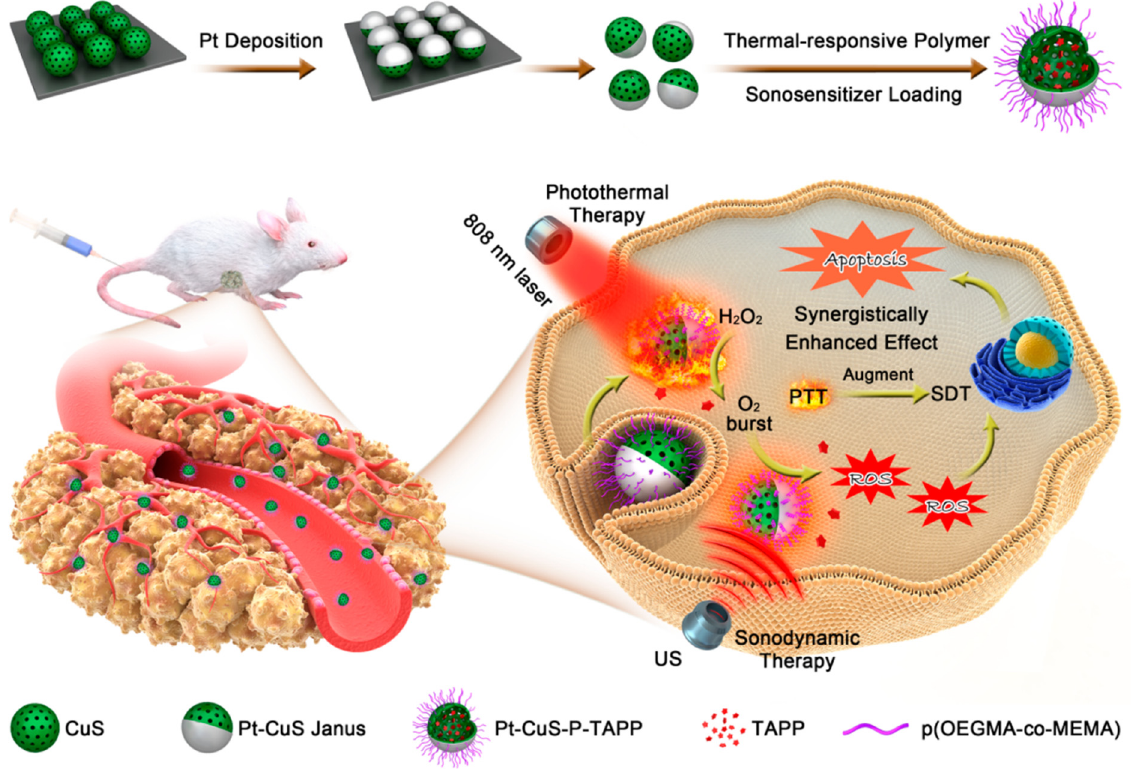
Figure 14. Schematic illustration of the main synthesis procedures and antitumor mechanism of PCPT [95]. To increase the photoactivation efficiency of PpIX, Sun et al. chemically modified it with jeffamines and then covalently conjugated it to PEGylated upconversion NPs (UCNPs) (Figure 15) [96]. The UCNPs–PJ was more hydrophilic, able to generate ROS under the excitation of 980 nm NIR light, and displayed potential for targeting tumors. The UCNPs– PJ probe was evaluated in vitro using the human colon adenocarcinoma cell line